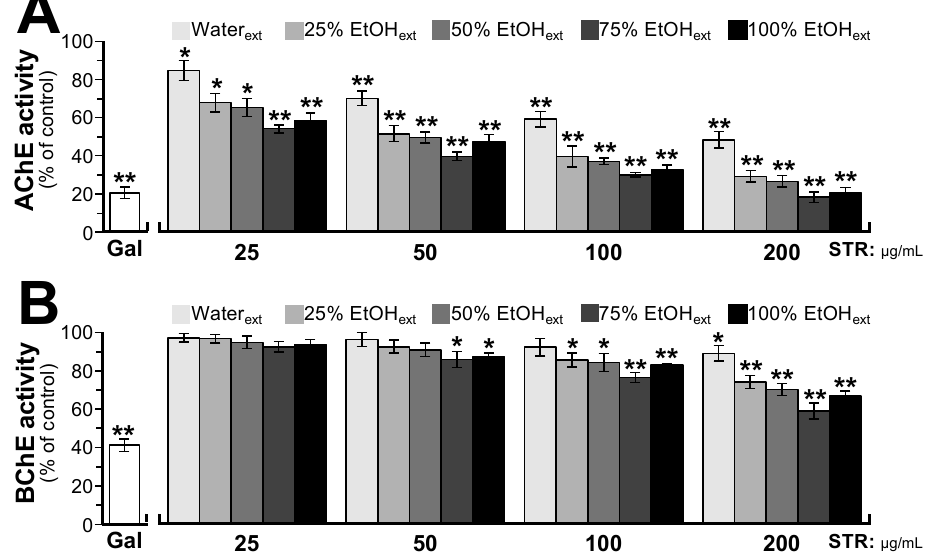
Figure 2. The water and ethanol extracts of STR inhibit cholinesterase activity. STR extracts using water and different fractions of ethanol (25%, 50%, 75%, and 100%) were tested for acetylcholinesterase (AChE) activity ( A ) and butyrylcholinesterase (BChE) activity ( B ). Galanthamine (Gal, 10 or 60 μM) served as a positive control for AChE or BChE activity. Data are expressed as the mean ± SEM (standard error of mean) of three dependent assays, each with triplicate samples. * p < 0.05 and ** p < 0.01 compared to control (no drug).